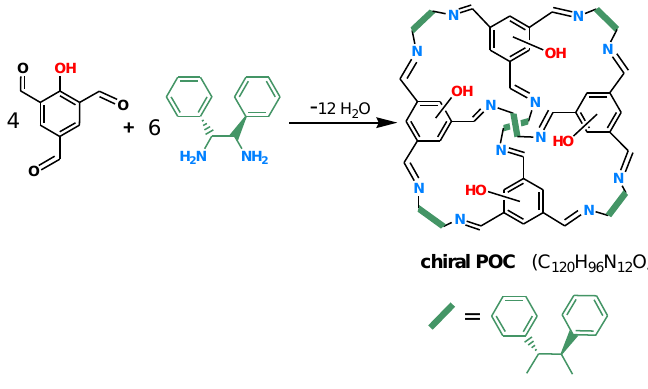
Figure 8. Synthesis of the chiral POC.